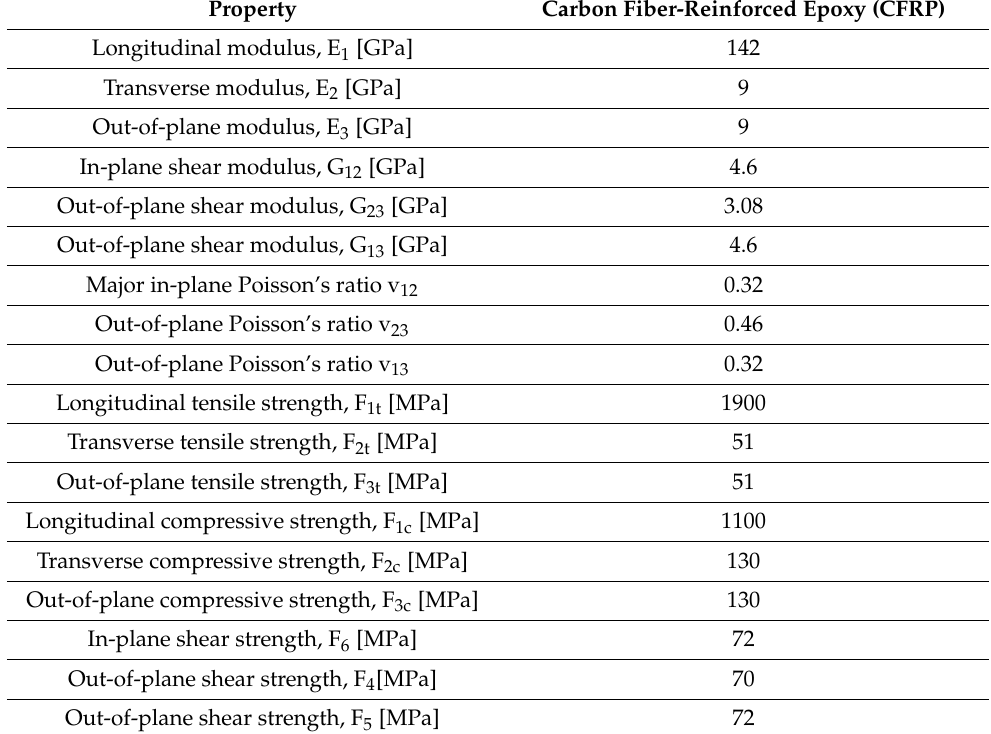
Table A7. Material properties, FAW200 prepreg moduli, and strength parameters from [17].